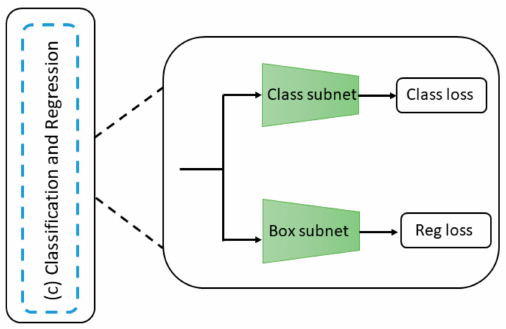
Figure 5. Architecture of the multi-scale feature extraction